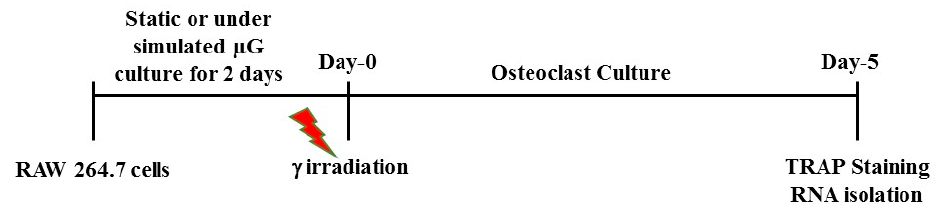
Figure 6. Timeline of the experiment. RAW 264.7 cells were cultured in static or under simulated microgravity for 48 h before exposed to varying doses of γ rays. Cells were then cultured in the presence of RANKL for 5 days for quantification of osteoclast differentiation and for gene expression analysis.